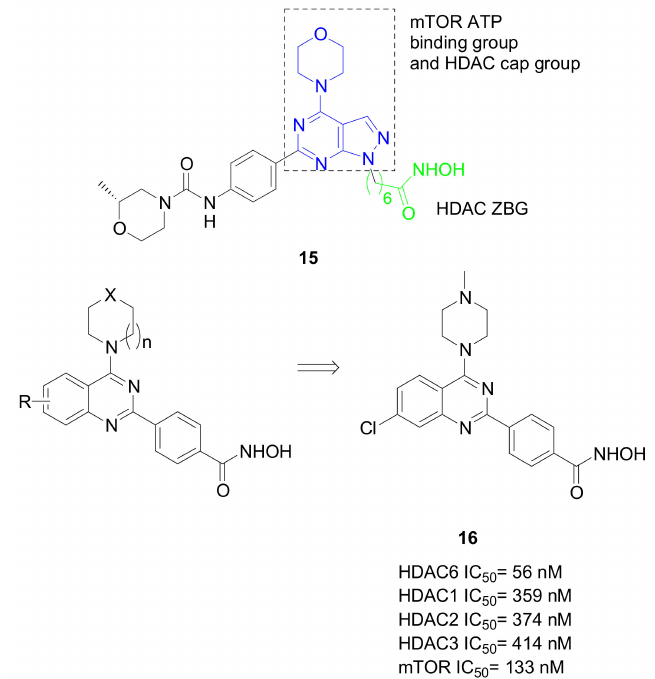
Figure 11. Chemical development of mTOR/HDAC inhibitors.